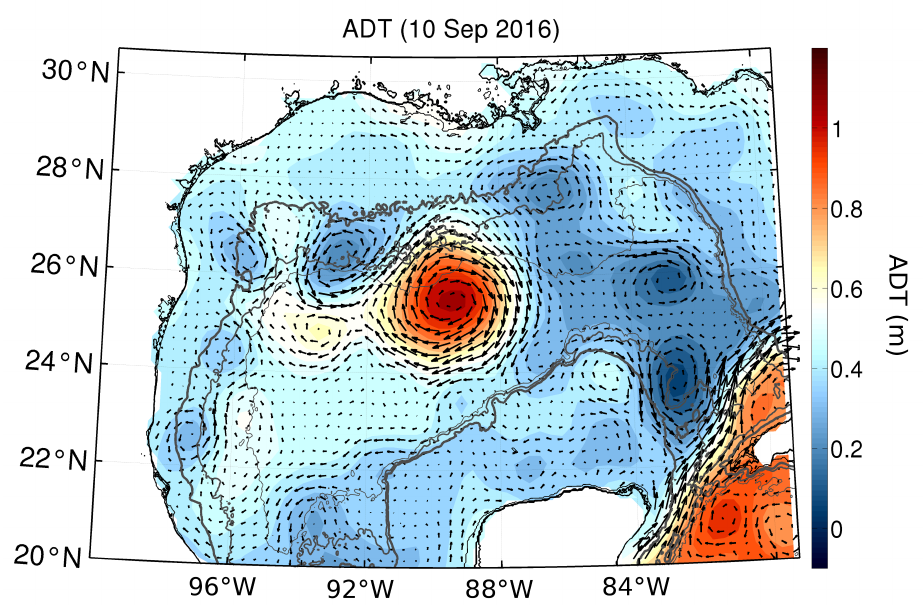
Figure 1. Map of AVISO-gridded absolute dynamic topography (ADT) in the Gulf of Mexico on September 10. The Loop Current Ring is evident as a circular anomaly of high ADT centered near 89 ◦ W 25.5 ◦ N. The geostrophic currents are plotted as arrows. The 500 and 2000 m isobaths are plotted as thick gray